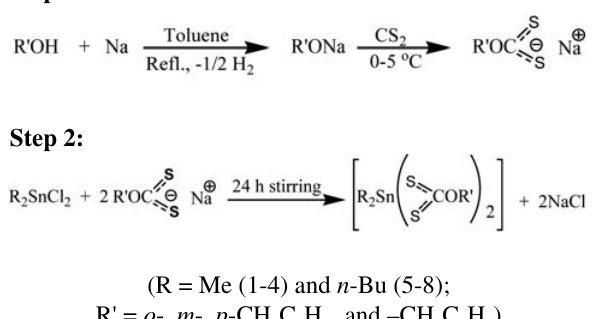
Table 1. Summary of the crystal structure, data collection and structure refinement parameters for the complex [ ( n -Bu) ] ( 8) COCH C H ) (S 2 2 6 5 2